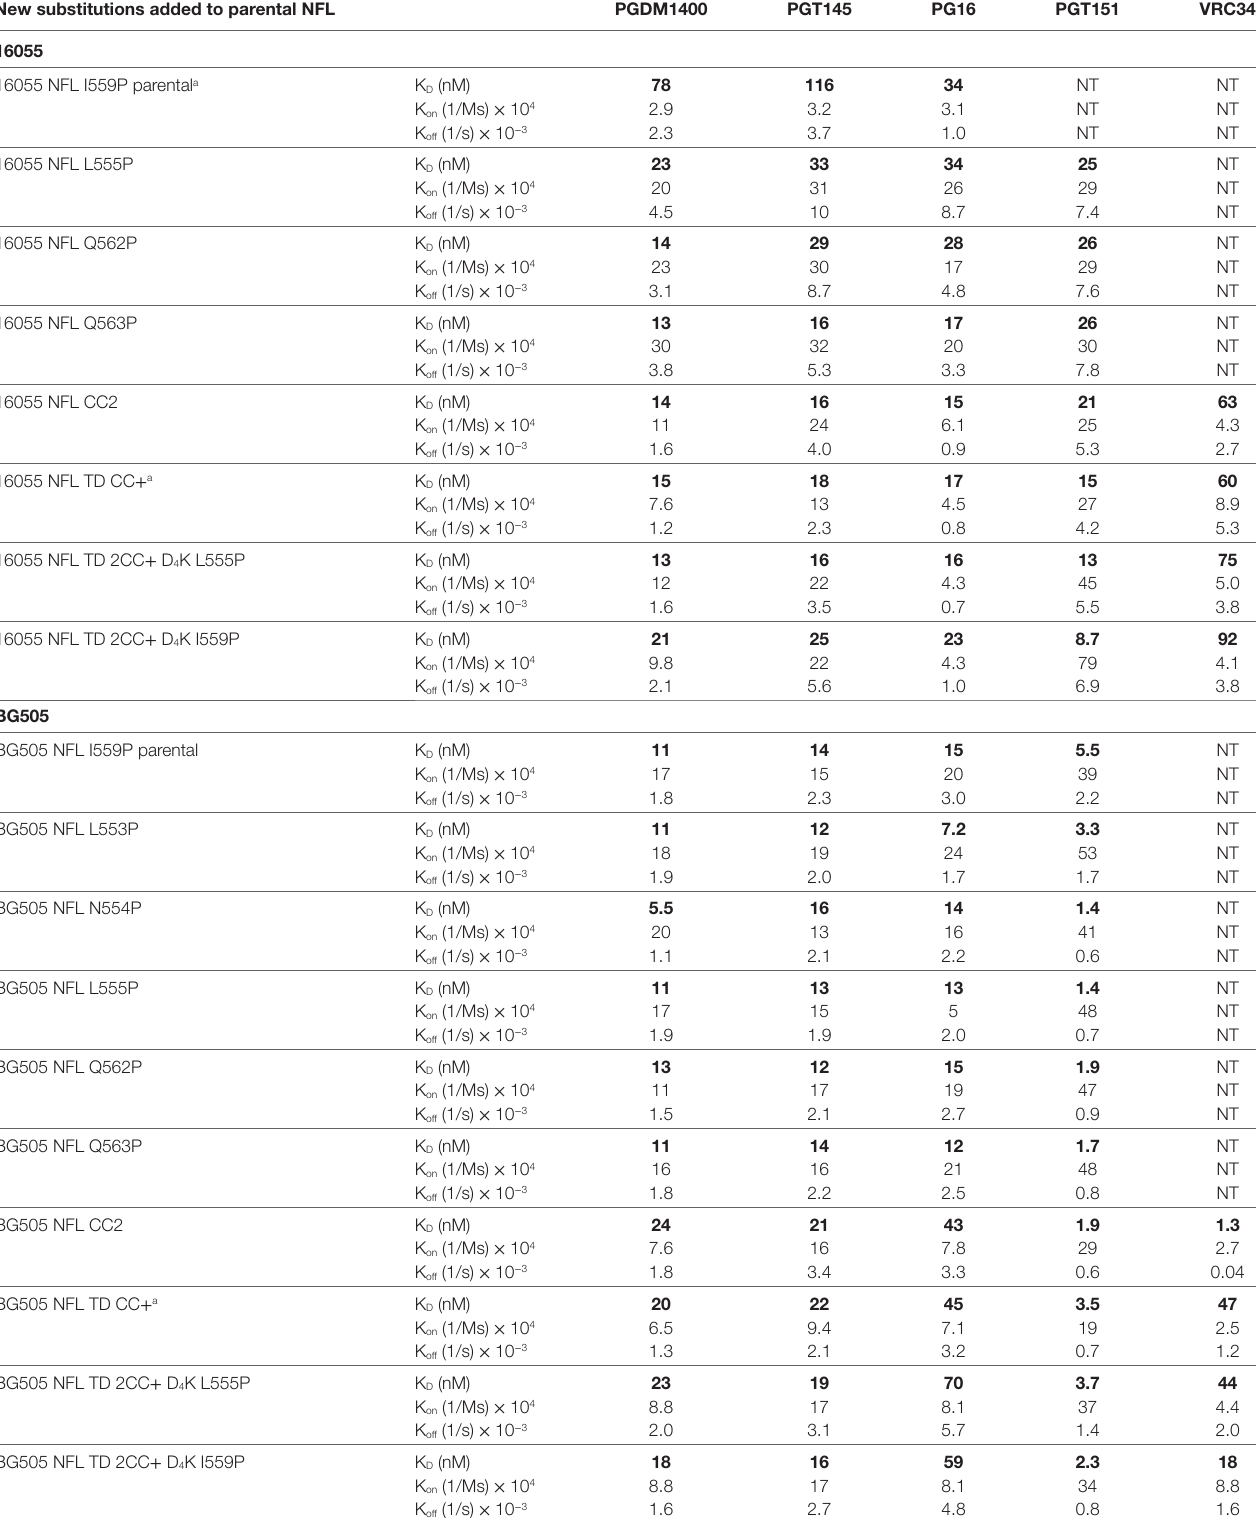
TaBle 3 | Kinetic parameters of the NFL trimers with trimer-preferring V2-apex and cleavage-sensitive bNAbs. new substitutions added to parental